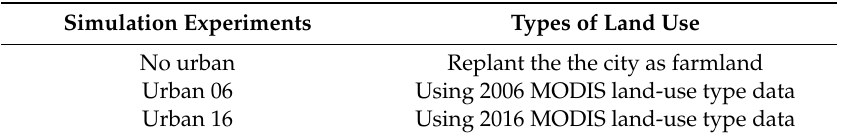
Figure 1. Domain configuration and location of the study area.